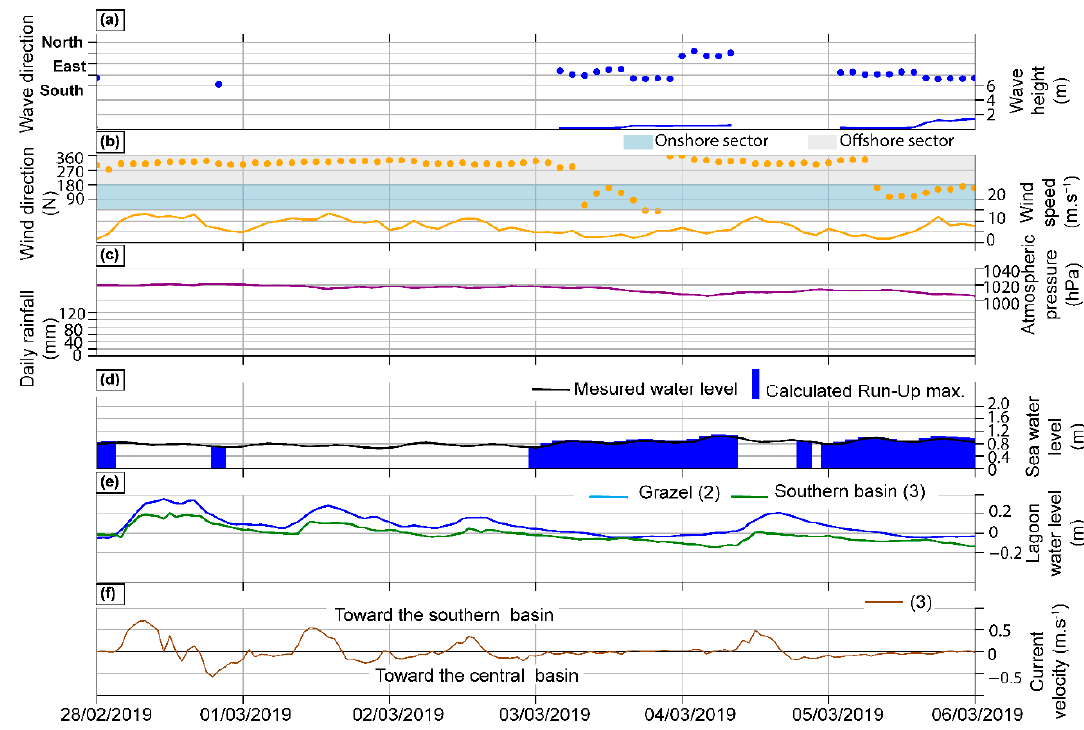
Figure 3. Recorded hourly forcing conditions during hydrodynamic monitoring with closed in- let. ( a ) Wave conditions measured at the Leucate buoy (periods of offshore-directed waves are not indicated for sake of clarity); ( b ) Wind conditions; ( c ) Precipitation and atmospheric pressure; ( d ) Water-level variations between the southern basin (green, see 3 in Figure 1); ( e ) Grazel (blue, see 2 in Figure 1); ( f ) Current velocities measured at location 3 between the southern basin and Grazel (black, see 3 in Figure